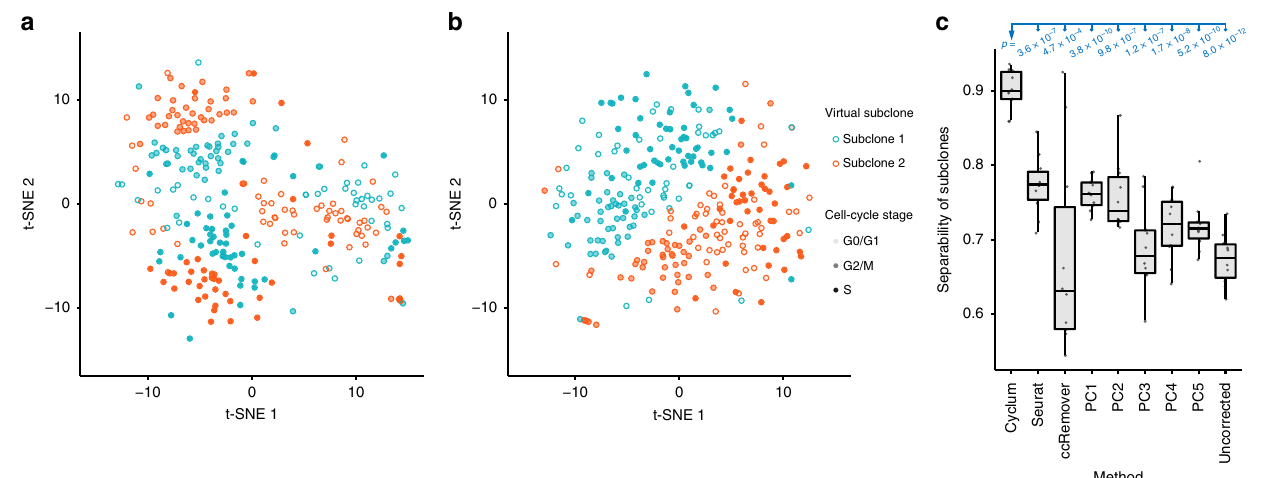
Fig. 3 Subclone detection from virtual tumor data. a t-SNE plot of the virtual tumor data consisting of two subclones (blue and red dots) of 288 cells each at various cell-cycling stages (shades). b t-SNE plot of the data corrected for cell-cycling effects using Cyclum. c The separability of subclones of n = 10 randomly generated virtual tumor datasets corrected by Cyclum, Seurat, ccRemover, principal component (PC) 1~5, and the uncorrected data. The median (center lines), interquartile range (hinges), 1.5× interquartile range (whiskers), and corresponding data points (dots) are shown. P -values were calculated using two-tailed Student ’ s t -test. The expression levels of 1600 genes, including 600 known cell-cycle genes that were doubled in creating the virtual tumor data. Each method was evaluated fi ve times on each dataset and the best accuracy is recorded. In this context, n denotes sample size, not to be confused with number of cells in Methods. For all subpanels, source data are provided as a Source Data fi le.